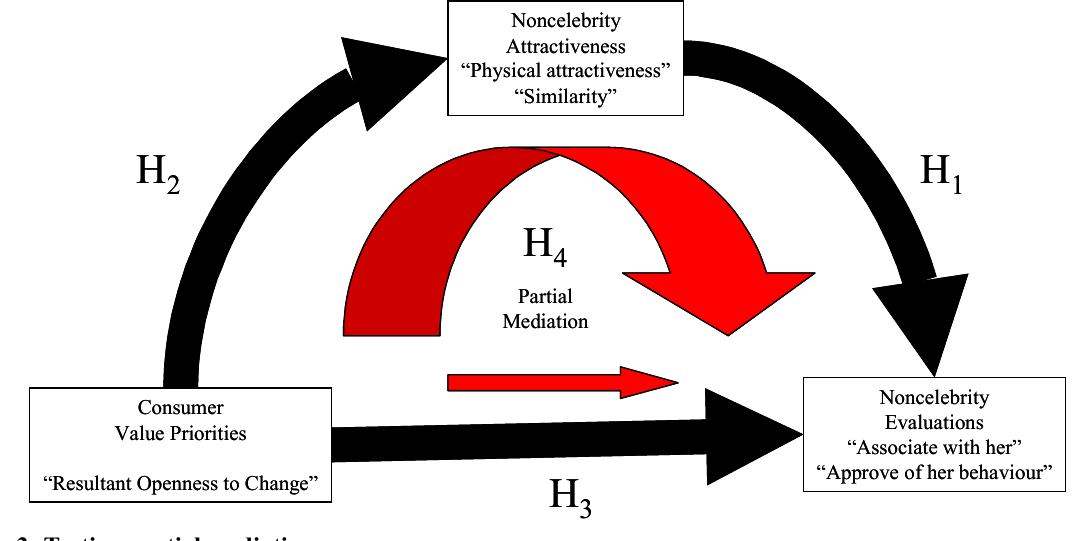
Figure 3: Testing partial mediation Note: See Baron and Kenny